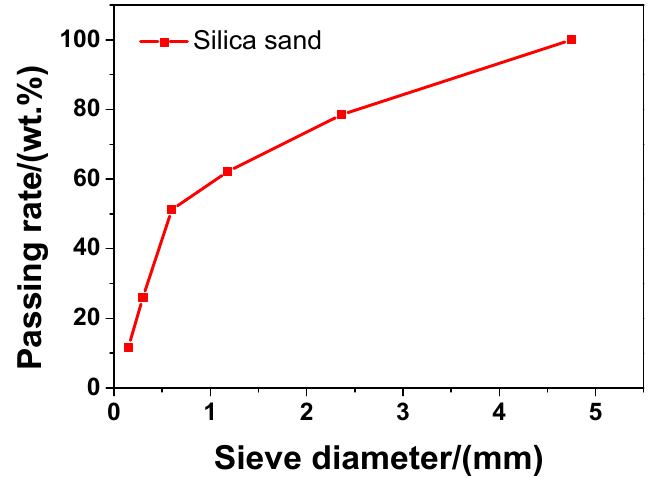
Figure 1. The particle size distribution of cement, silica fume, and fly ash. Figure 1. The p article size distribution of cement, silica fume, and fly ash.